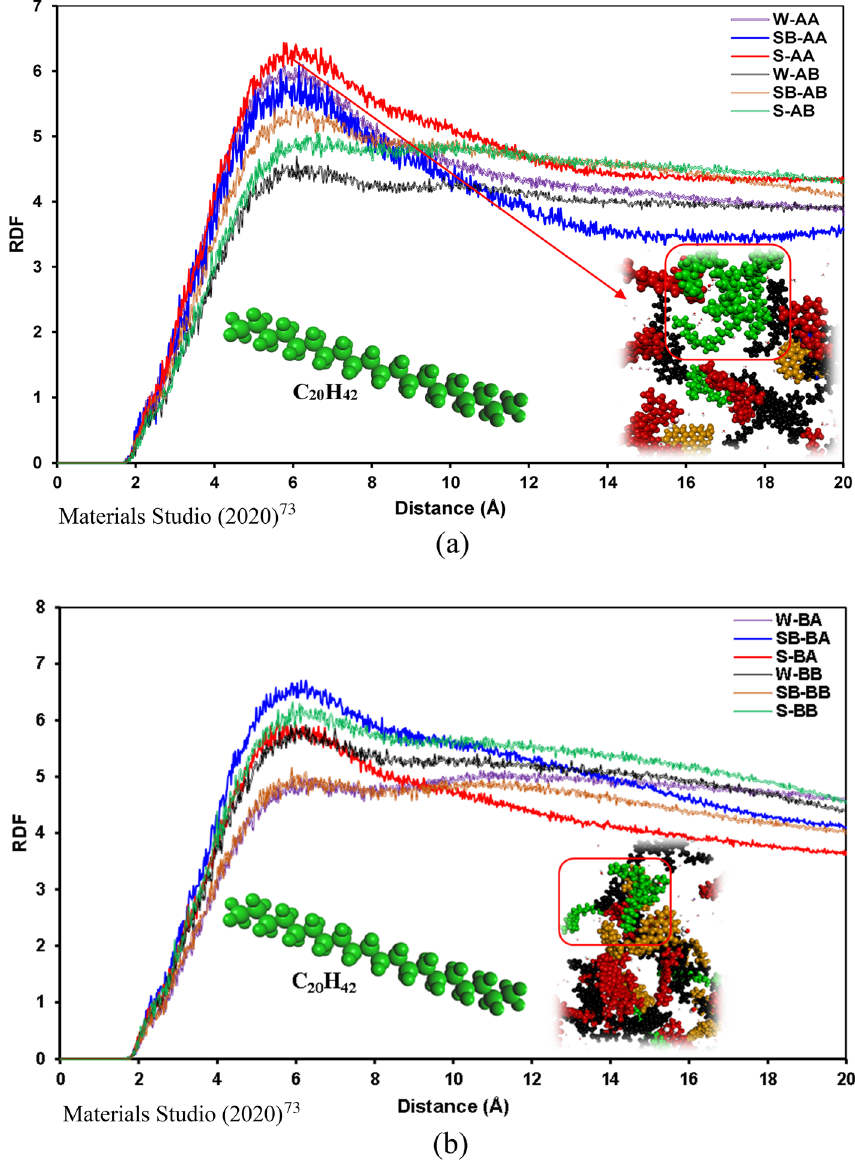
Figure 9. RDF of the saturate–saturate molecule pairs containing ( a ) C 40 H 30 O 2 and ( b ) C 44 H 40 N 2